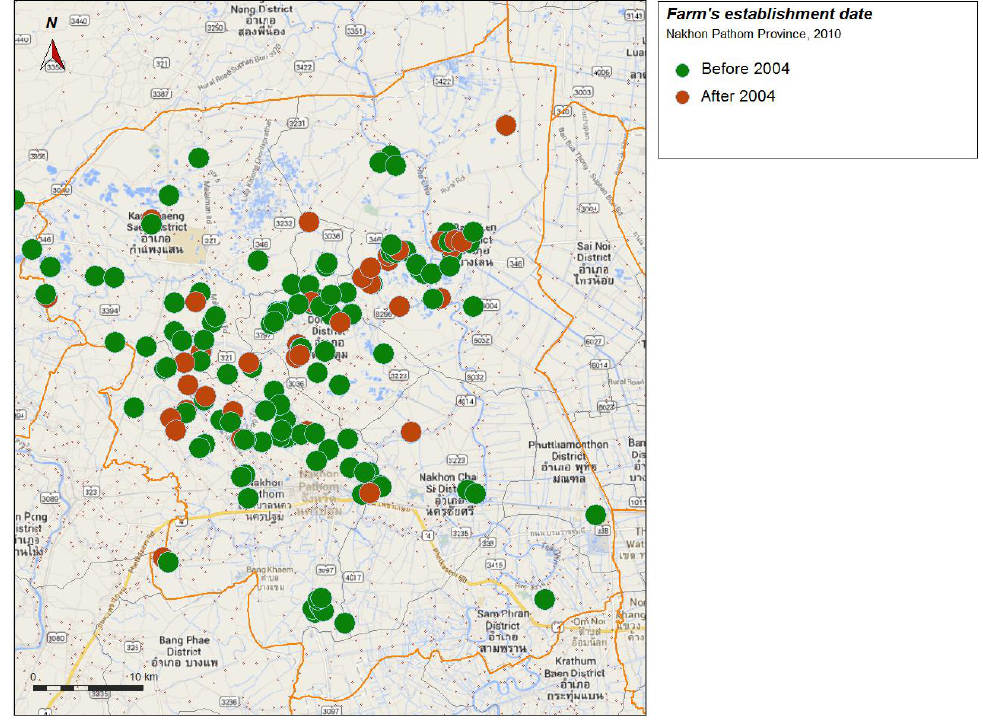
Figure 3. Farms in the survey and date of establishment (green: before 2004, brown: after